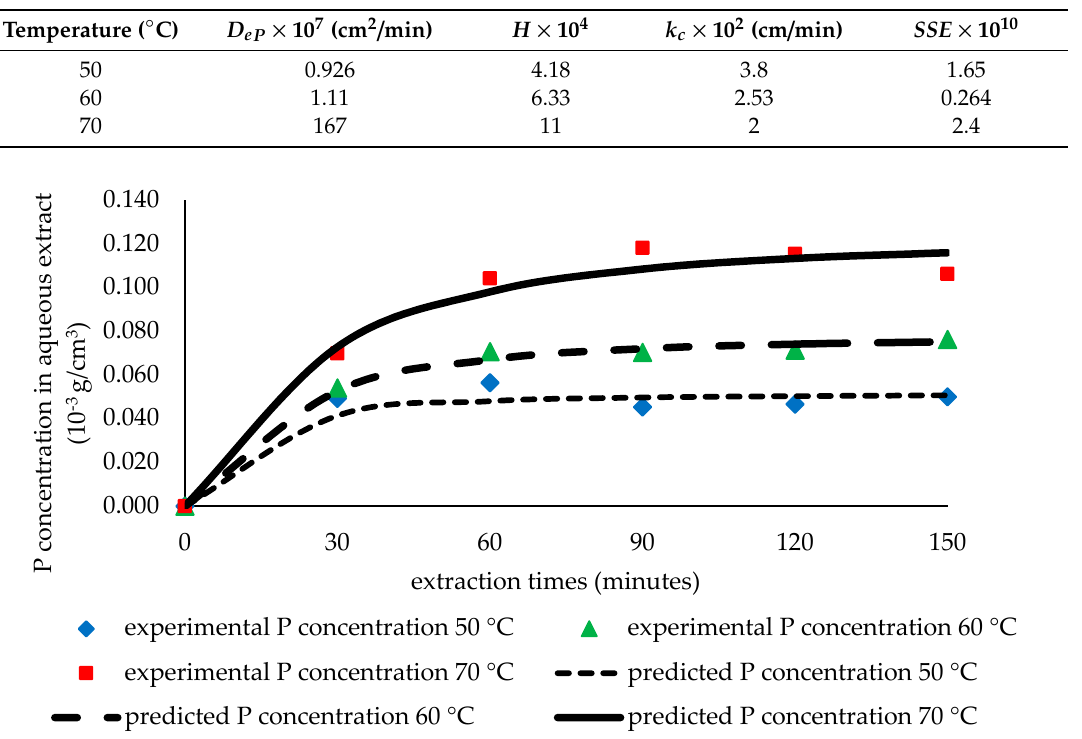
Figure 9. The comparison of the predicted and experimental P concentration in solvent.